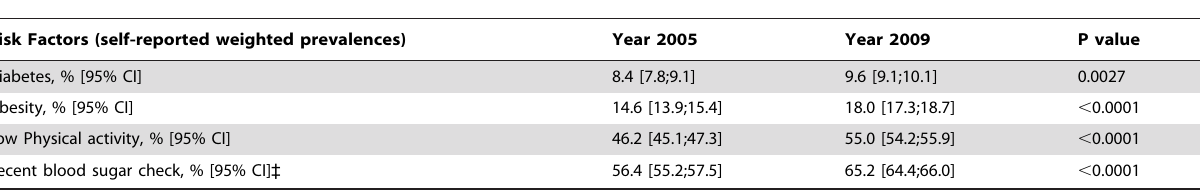
Table 2. Prevalence of Risk factors and main predictor